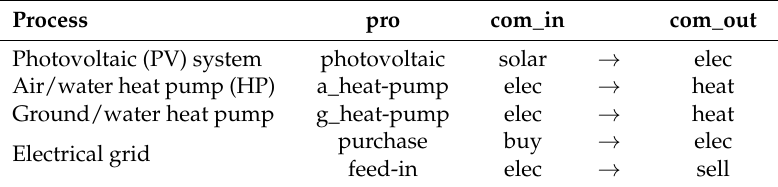
Table 6. Portfolio of processes applied.